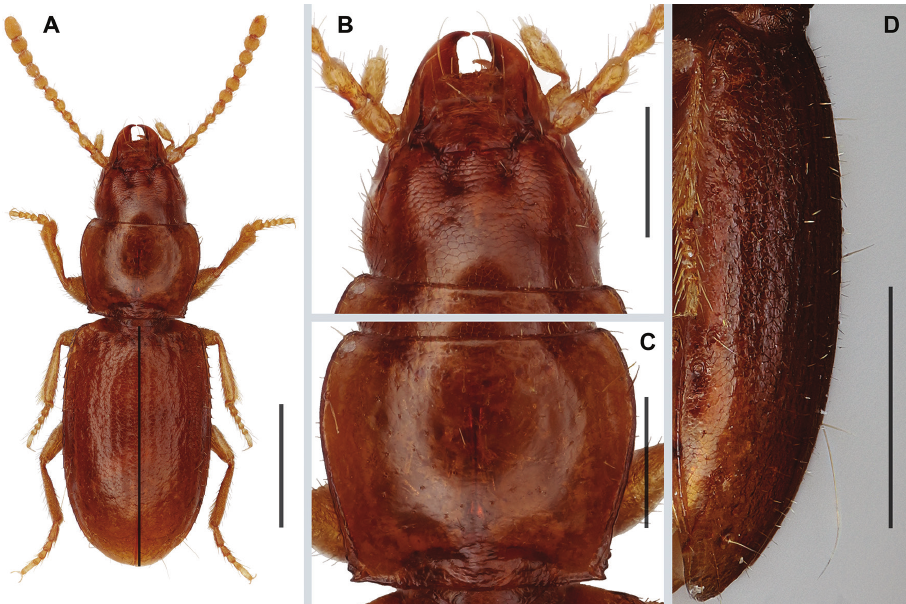
Figure 1. Digital images of external features of Anillinus felicianus sp. nov. (male, 4 mi SW of Jackson, West Feliciana Parish, Louisiana) A habitus, dorsal aspect B head, dorsal aspect C pronotum, dorsal as- pect D elytral vestiture, left lateral aspect. Scale bars: 0.5 mm ( A, D ); 0.2 mm ( B, C